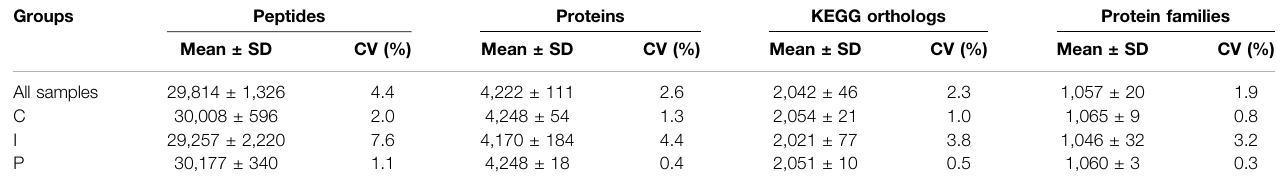
TABLE 1 | Shotgun proteomics analysis metrics. SD, standard deviation; CV, coef fi cient of variation; C, control diet; I, insect meal diet; P, poultry by-products meal diet. Groups Peptides Proteins